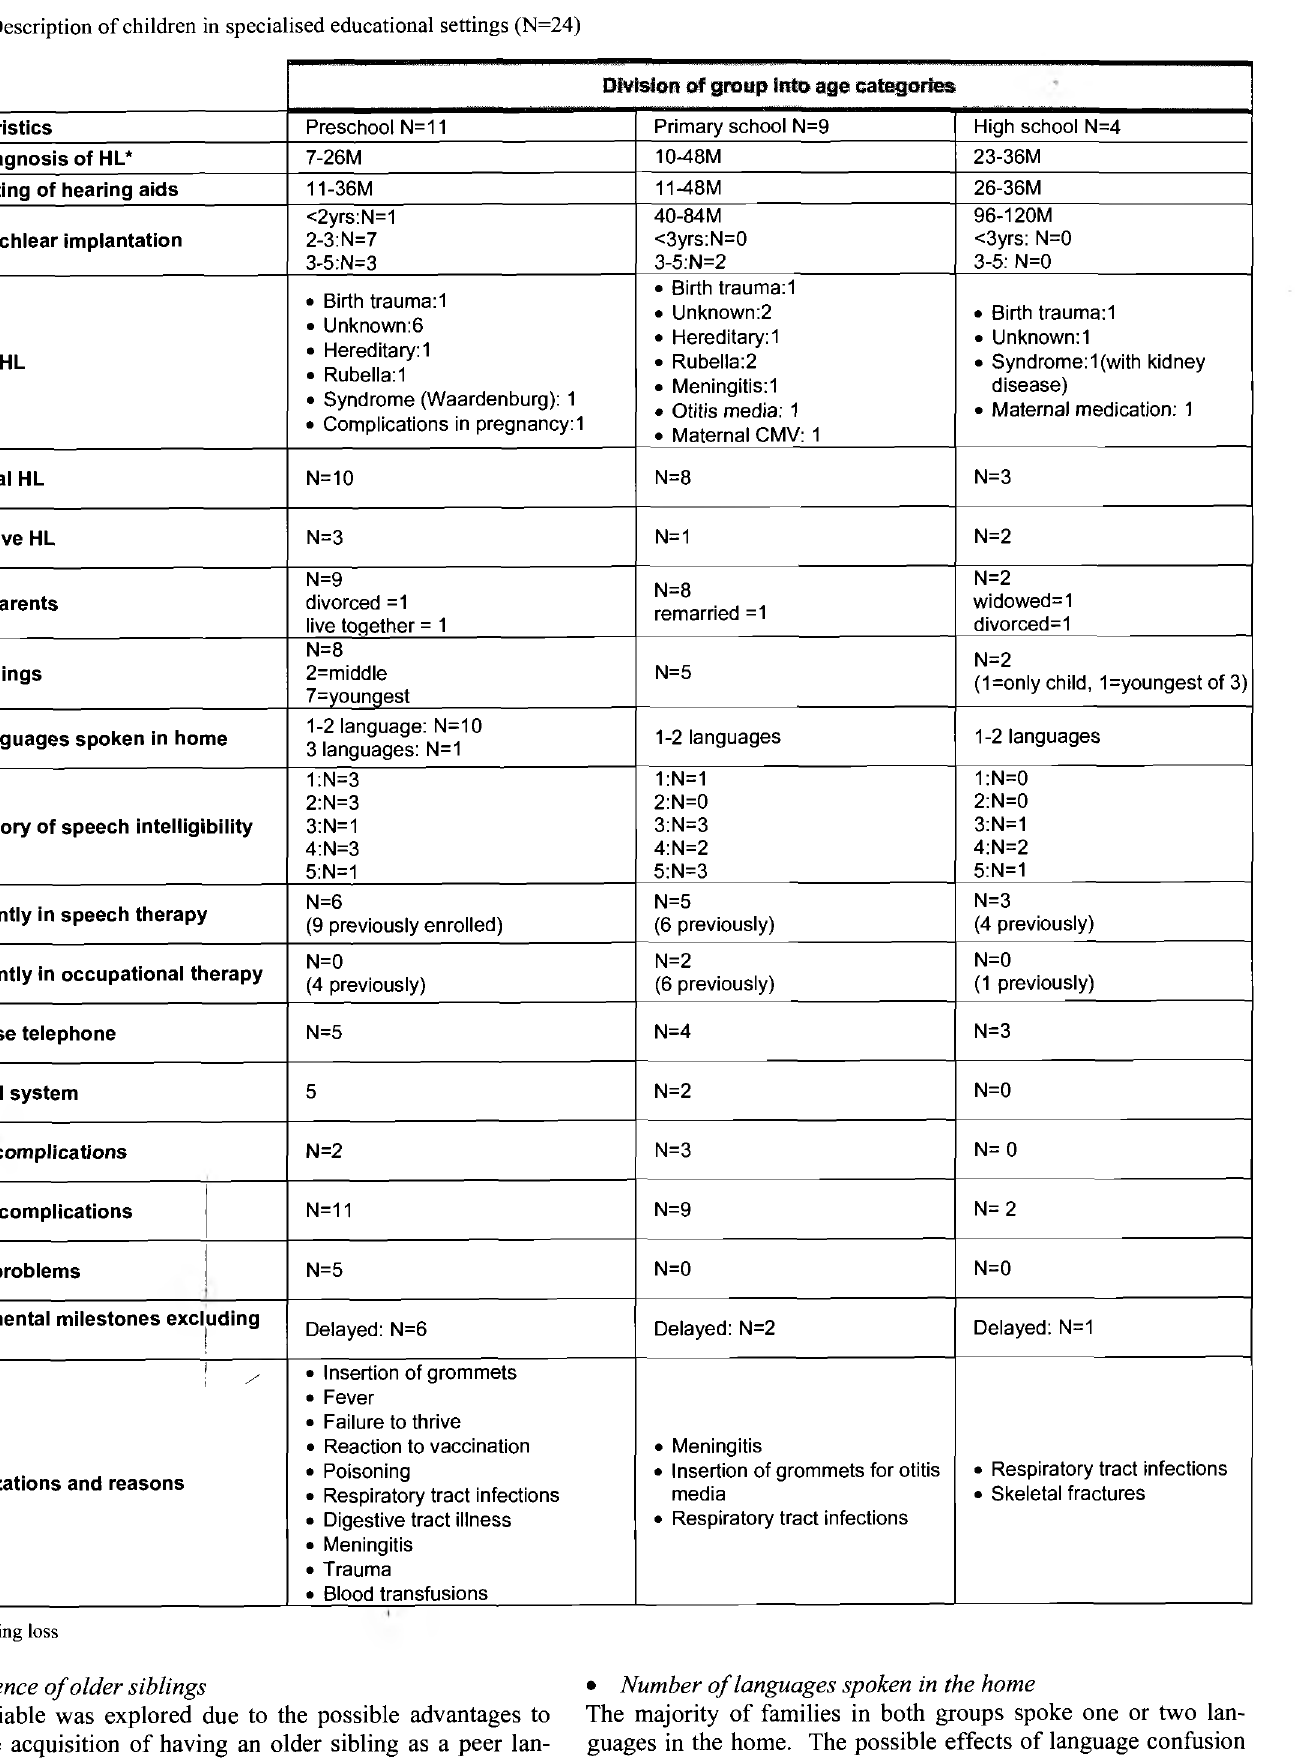
Table 4. Description of children in specialised educational settings (N=24)